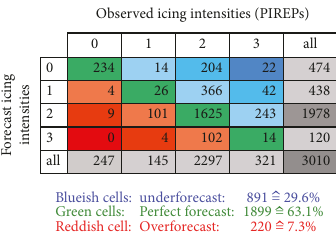
Figure 8: Multicategory contingency table for the final Har- monICE forecast, created using the PTmethod, using a box size of 3v7h (see Figure 7).